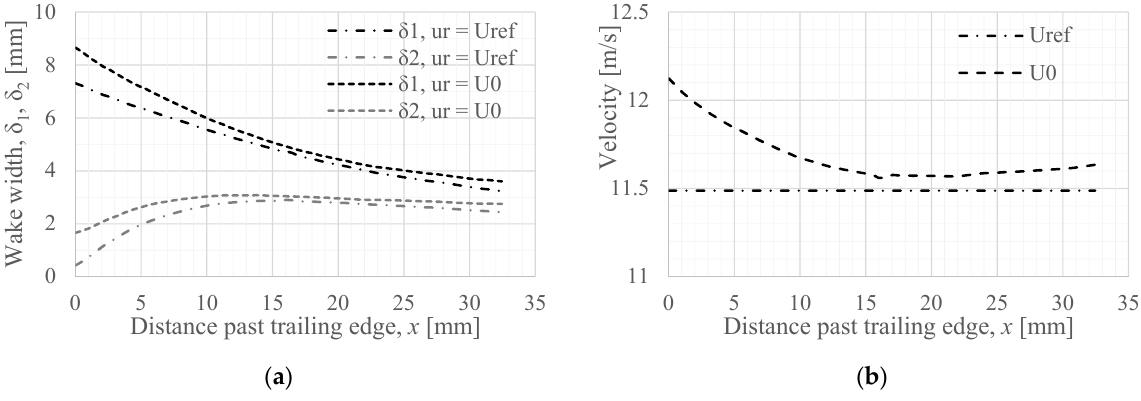
Figure 3. ( a ) Wake width calculated according to the formulas for boundary layer thickness. The dash-dotted lines represent the calculation with constant u r = U ref , while the dashed line plays for usage of u r = U 0 , which is the background of Gaussian fit and it develops with distance x . Dependence of these two velocities on x is displayed in panel ( b ).